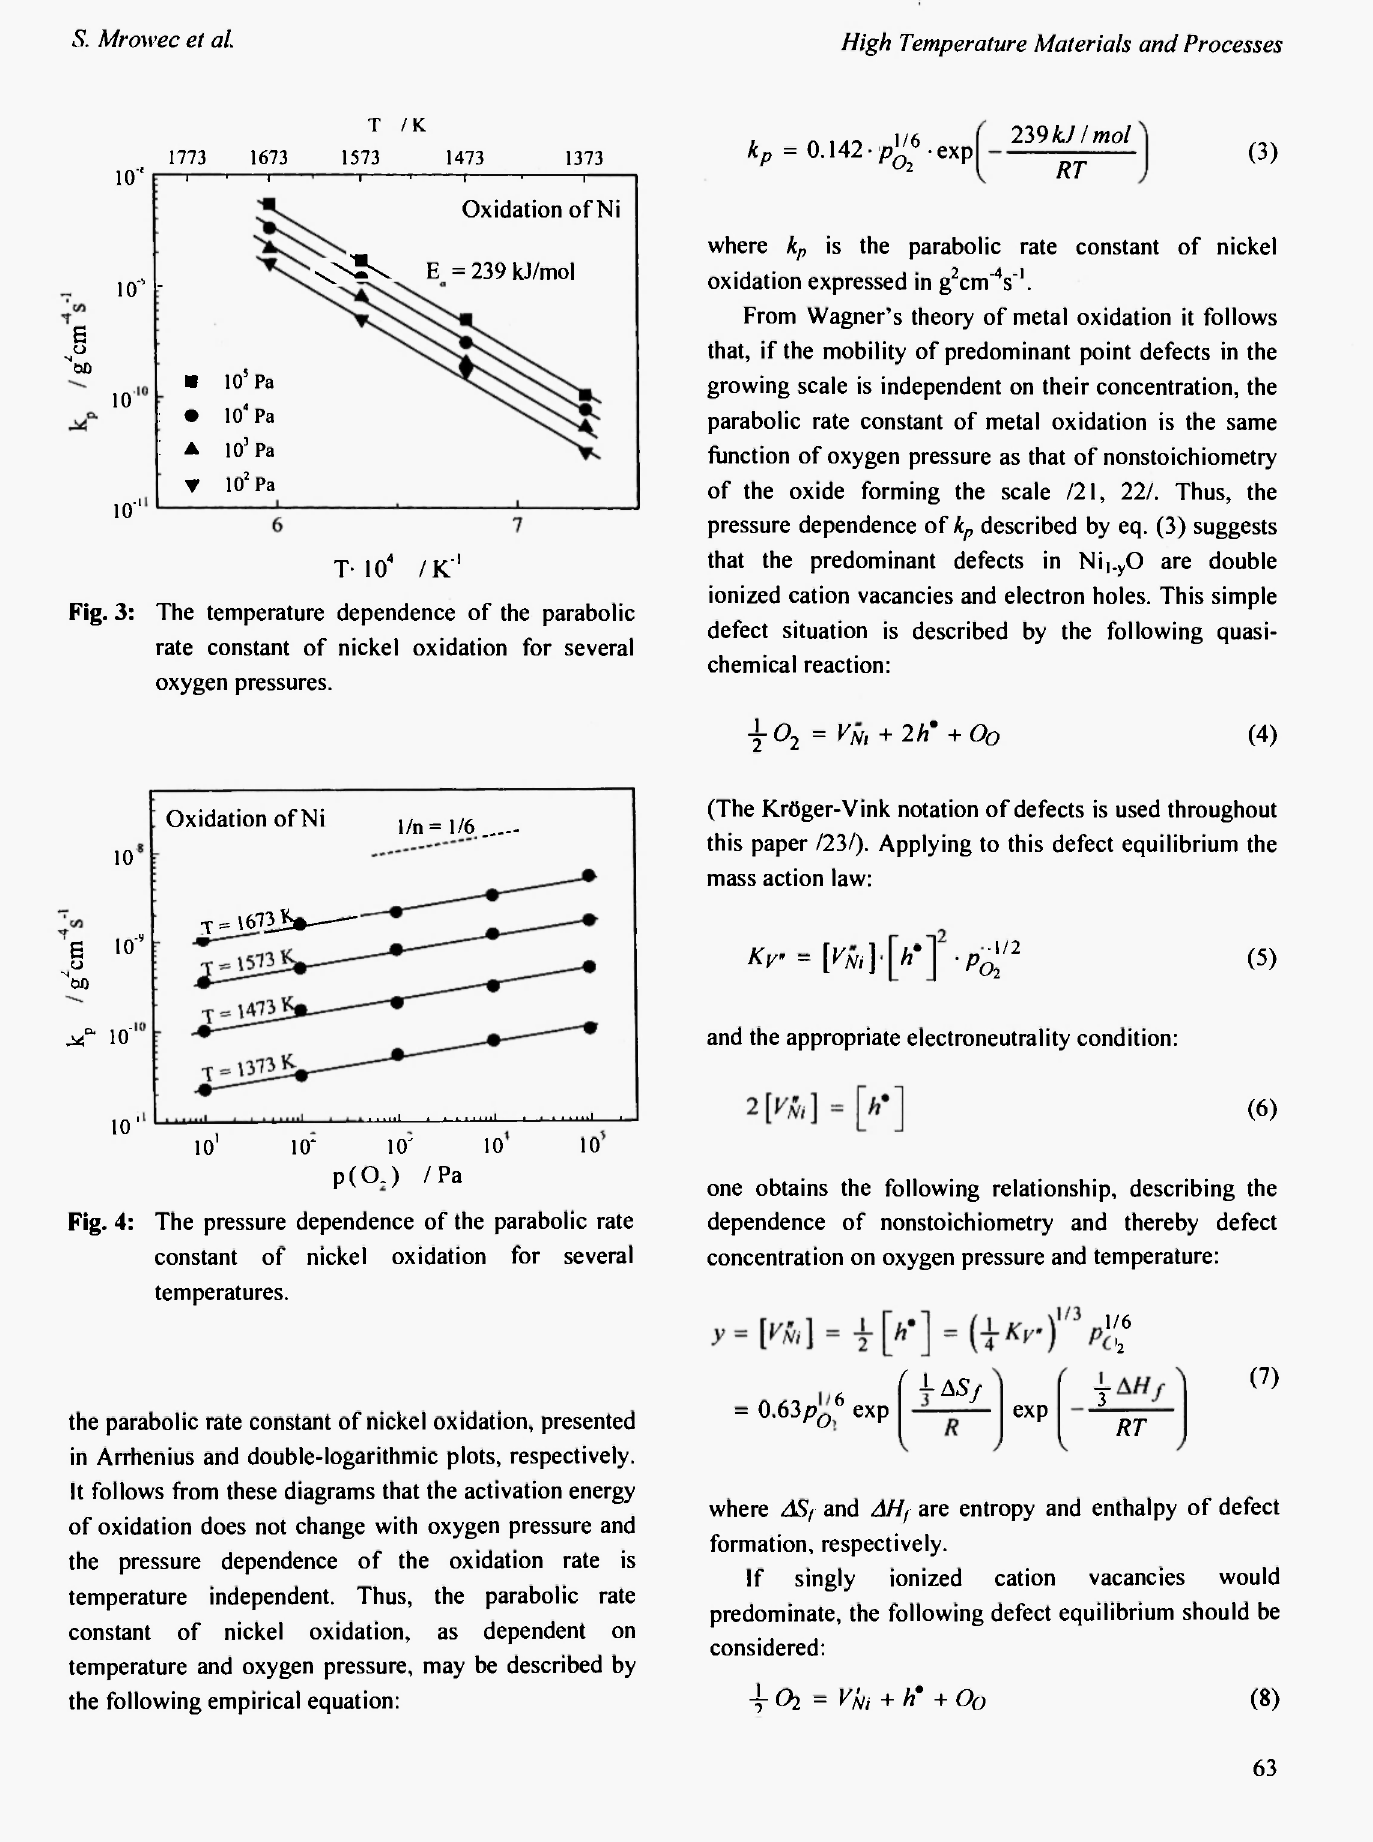
Fig. 4: The pressure dependence of the parabolic rate constant of nickel oxidation for several